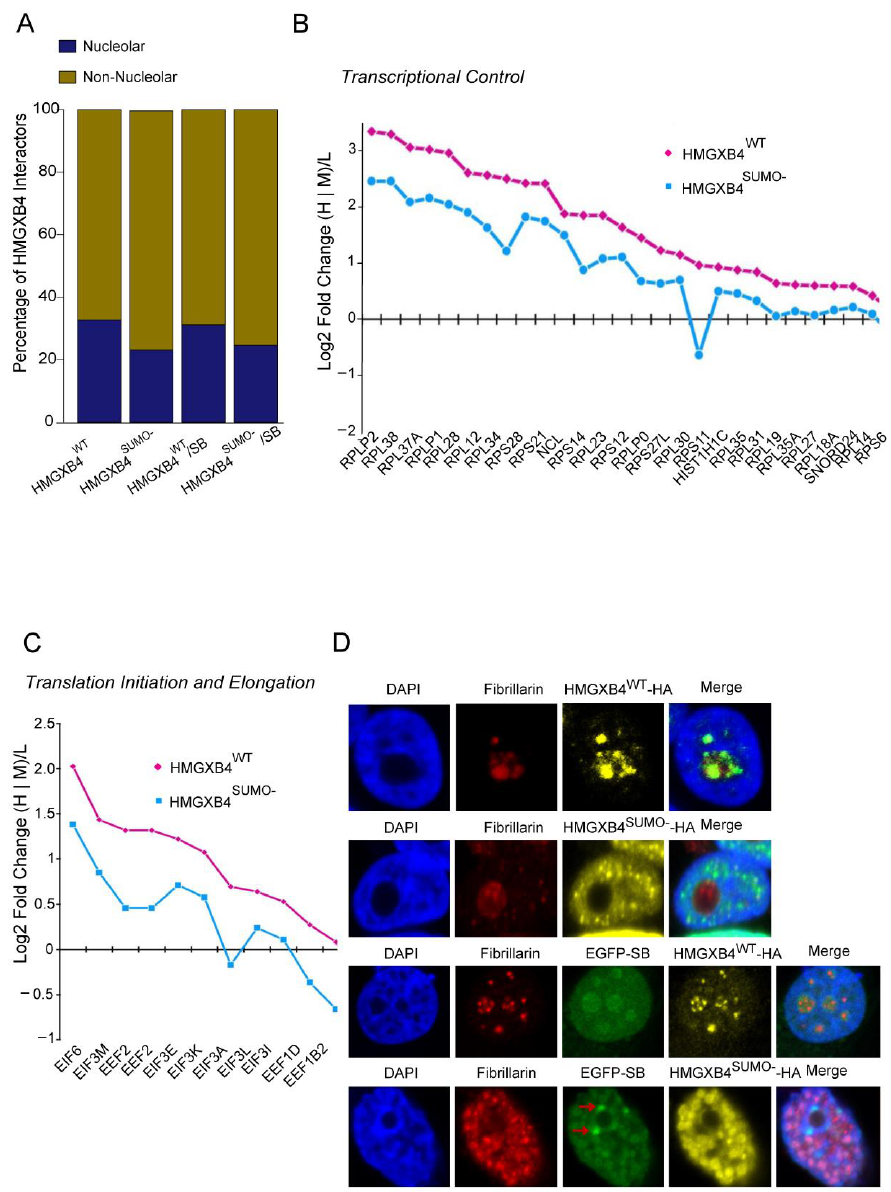
Figure 3. SUMOylated HMGXB4 is Compartmentalized to the Nucleolus. ( A ) SUMOylation affects the affinity of HMGXB4 to its nucleolar interacting partners. The stacked bar plot visualizes the differential affinity of HMGXB4 and HMGXB4 SUMO- with nucleolus-associated proteins in the pres- ence and absence of the SB transposase. ( B ) Line plots display the effect of SUMOylation on the affinity of HMGXB4 to a selected set of protein-interacting partners involved in Transcriptional